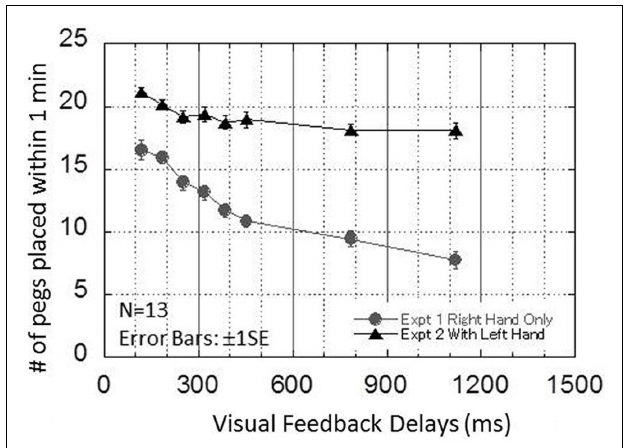
FIGURE 5 | Results obtained in experiment 2. This graph plots the performance of the pegboard task as a function of the visual delays from 120 to 1120ms in eight steps.The results obtained by the same 13 participants in experiment 1 are superimposed on the